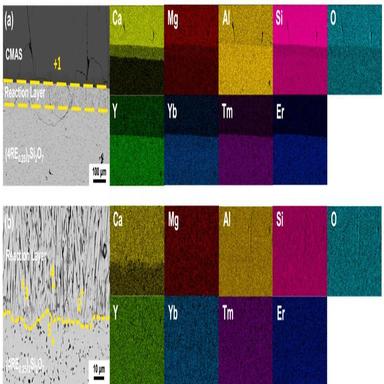
Cross sectional SEM images and corresponding elemental mappings of (Y0,25Er0,25Tm0,25Yb0,25)2Si2O7 after CMAS corrosion at 1300 ◦C for 2 h under (a) low magnification and (b) high magnification.